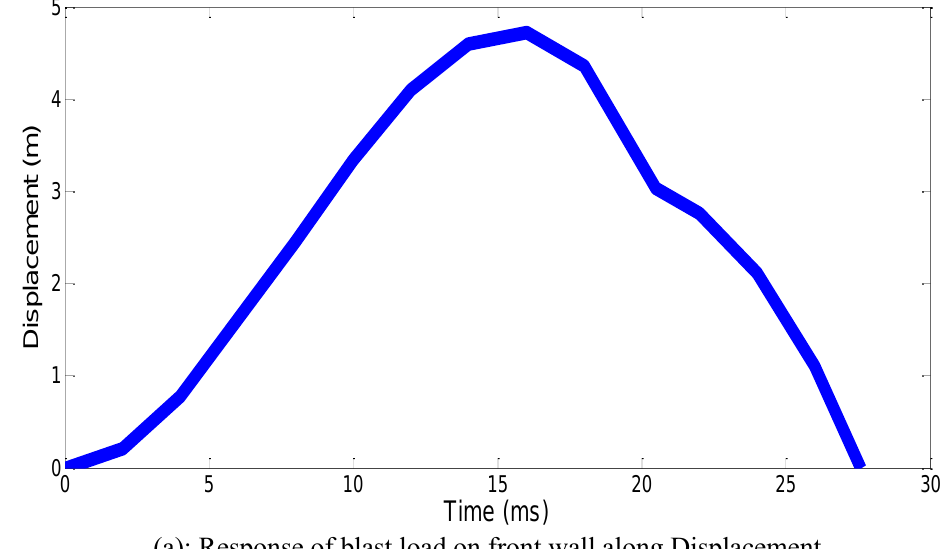
Fig. 3. Pressure time curve for front wall (9)